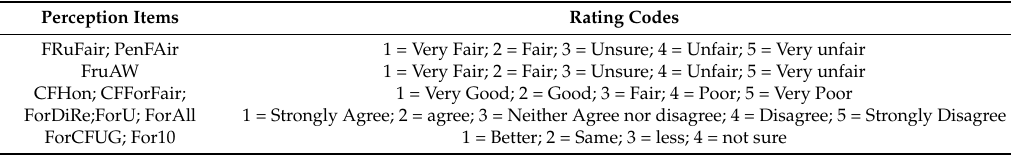
Table 3. Rating code for perception items in the household